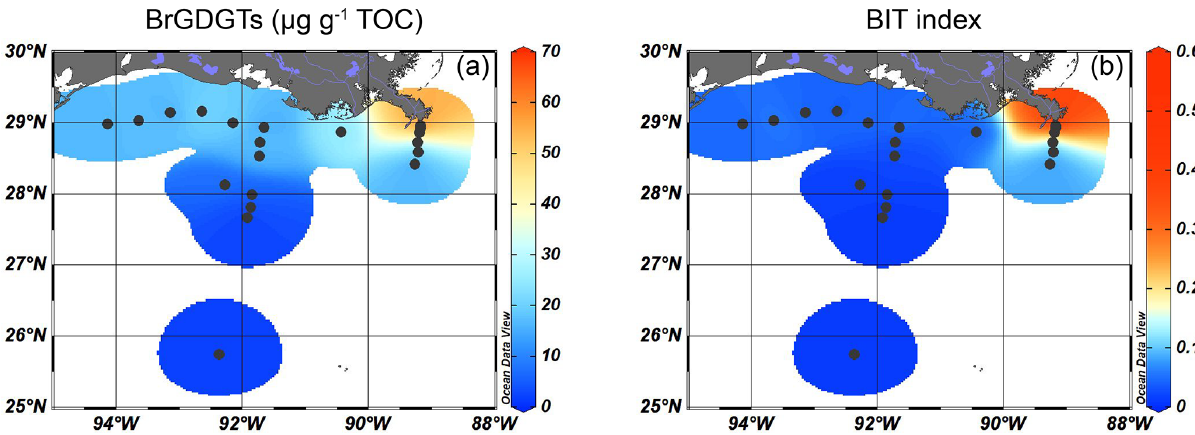
Figure 3. Isosurface plots of proxies for SMOM input for surface sediments in the GoM: (a) the concentration of brGDGTs (µgg − 1 TOC) and (b) the BIT index.